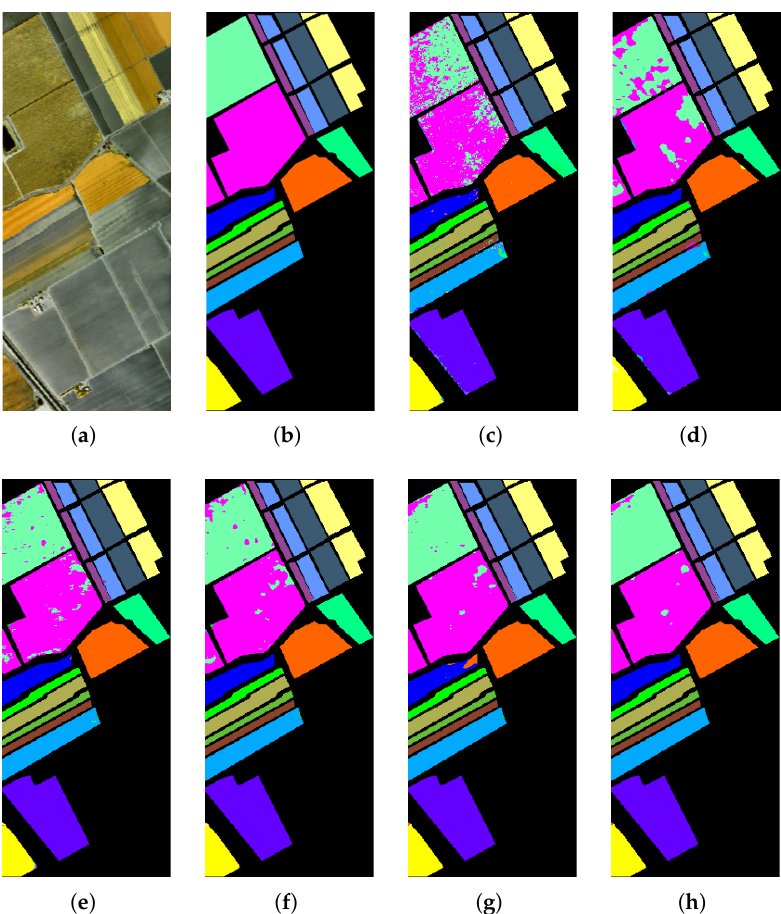
Figure 13. Classification performance of different network models over SV dataset. ( a ) False-color image. ( b ) Ground truth. ( c ) SVM. ( d ) 3-D CNN. ( e ) FDMFN. ( f ) DenseNet. ( g ) PresNet. ( h )